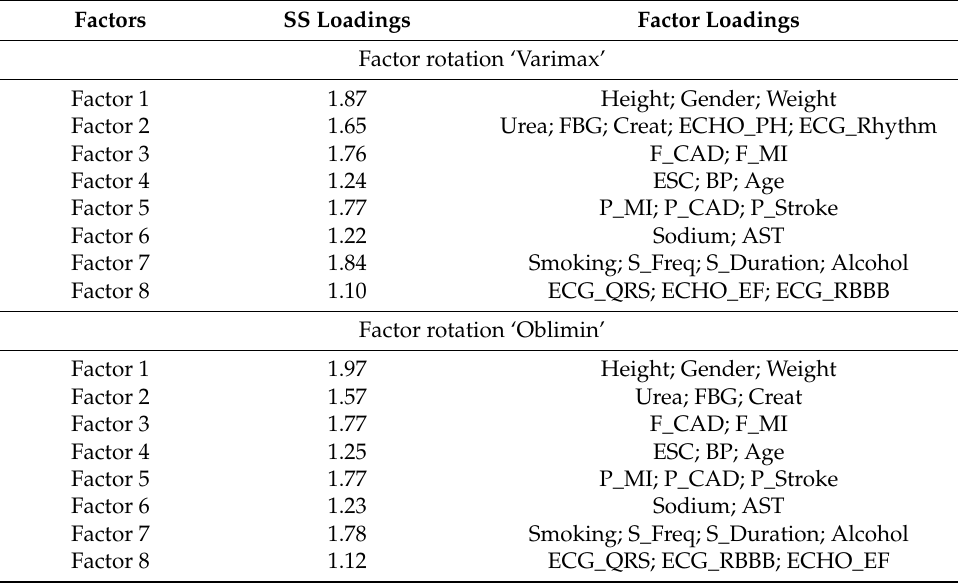
Table 5. SS loading values with factor loadings for individual solutions of